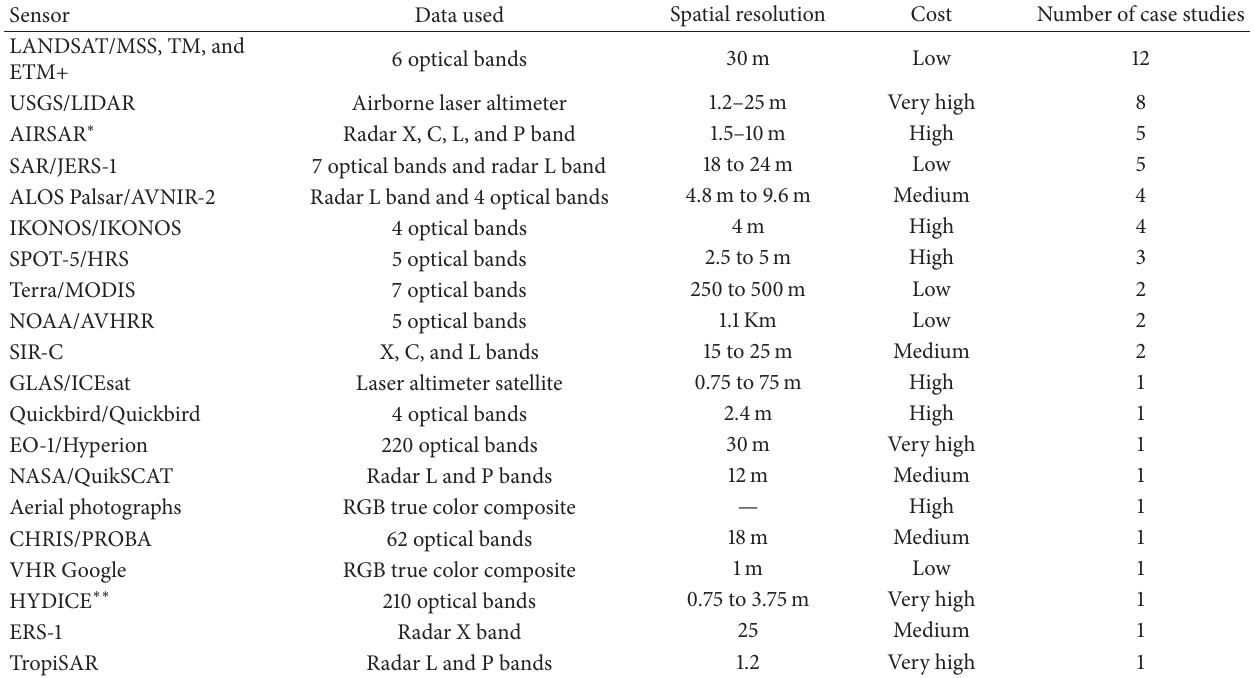
∗ AIRSAR: airborne synthetic-aperture radar.